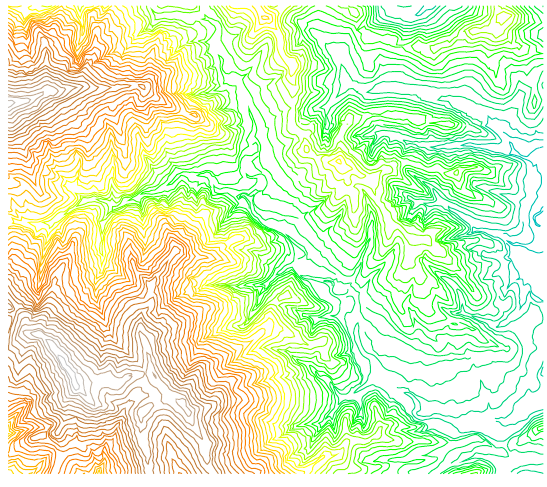
Figure 1. Sample contour line